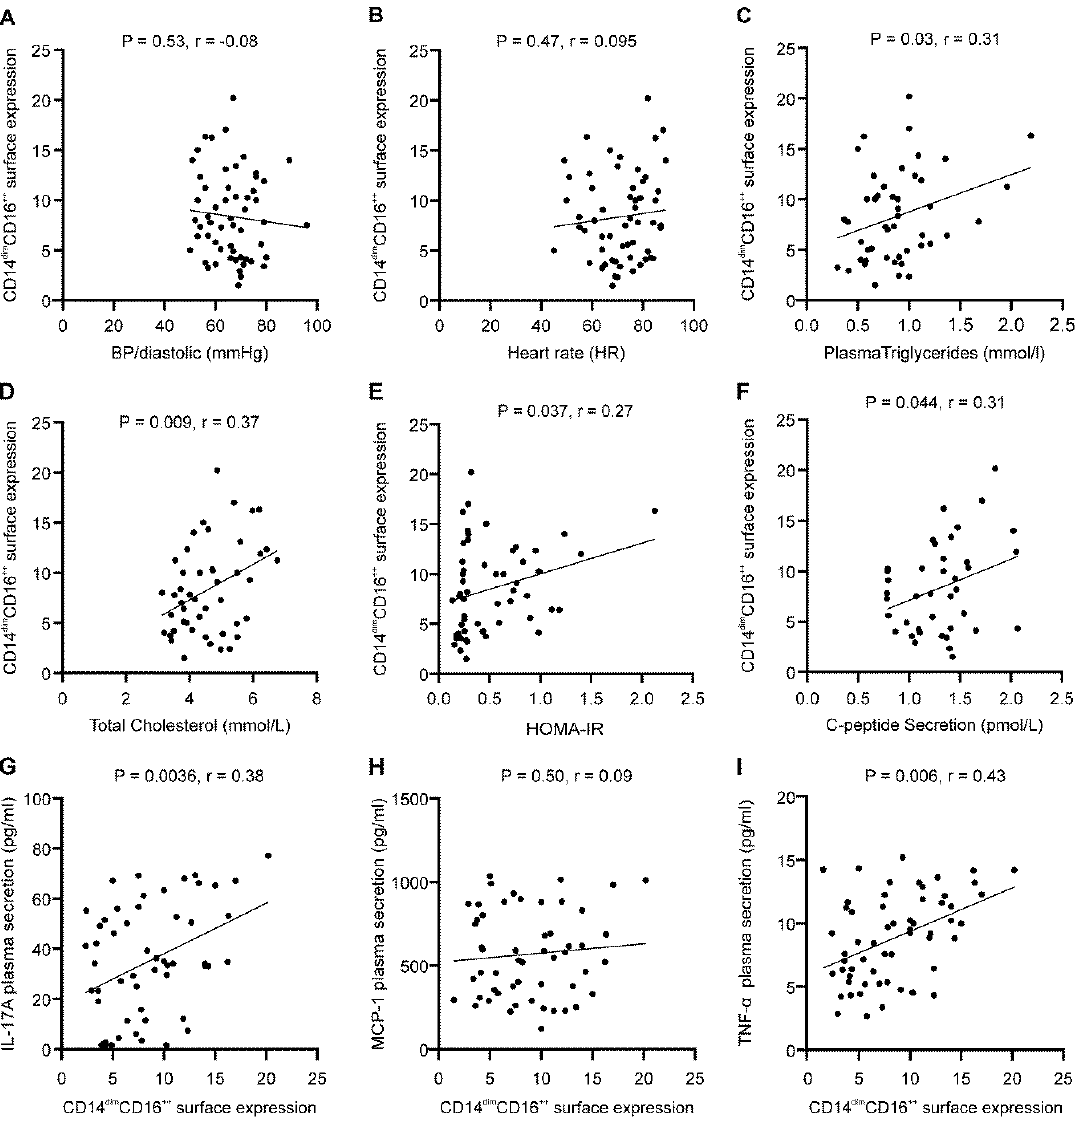
Figure 1. (A-I) Association between CD14 dim CD16 ++ monocyte subsets and insulin resistance syndrome (IRS) markers. Multiple linear regression analysis between non-classical blood monocyte counts and the changes in metabolic and inflammatory markers within the longer duration of PA group. All data are expressed as mean ± SD. p ≤ 0.05 was considered statistically significant (* p < 0.01; ** p < 0.001, *** p < 0.0001).